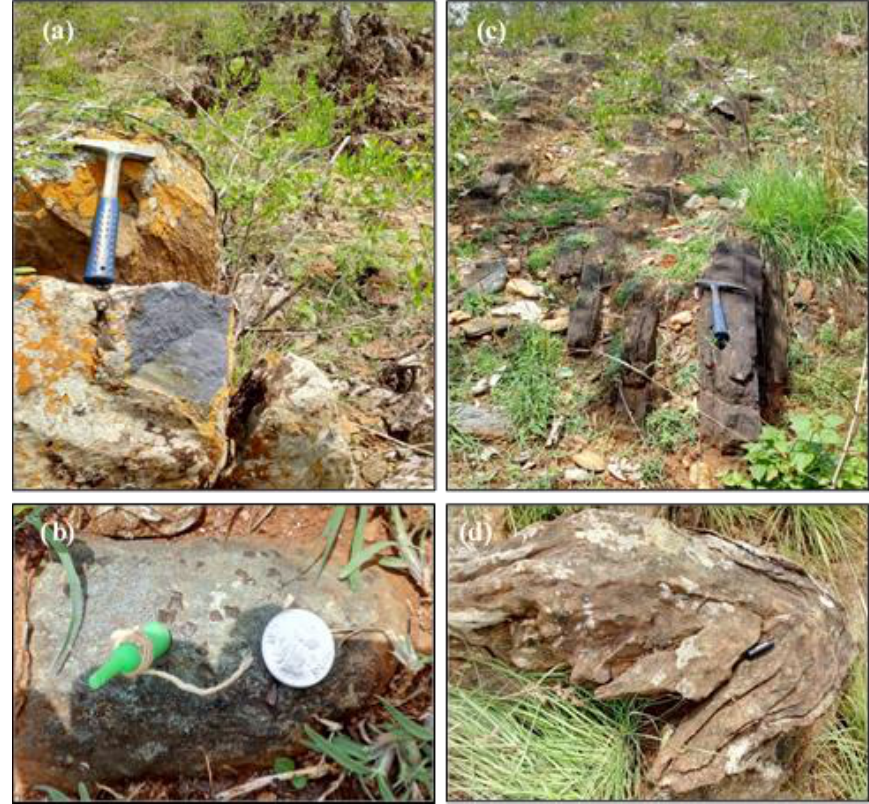
Figure 2. Field photograph of ( a ) high-Si high-Mg volcanics (boninite) that are relatively fresh and greyish in appearance underneath the weathered surface of the outcrop; ( b ) magnetite bearing metaultramafic rocks conformably juxtaposed with the high-Si high-Mg volcanics; ( c ) amphibolites (metabasalts) are conformably associated with the adjacent ultramafics; ( d ) second generation (F2) folds observed in the adjacent ultramafic outcrop. Note that, as shown in Figure 1, the entire volcanic package exhibits uniform foliation pattern, and consistent grade of metamorphism.